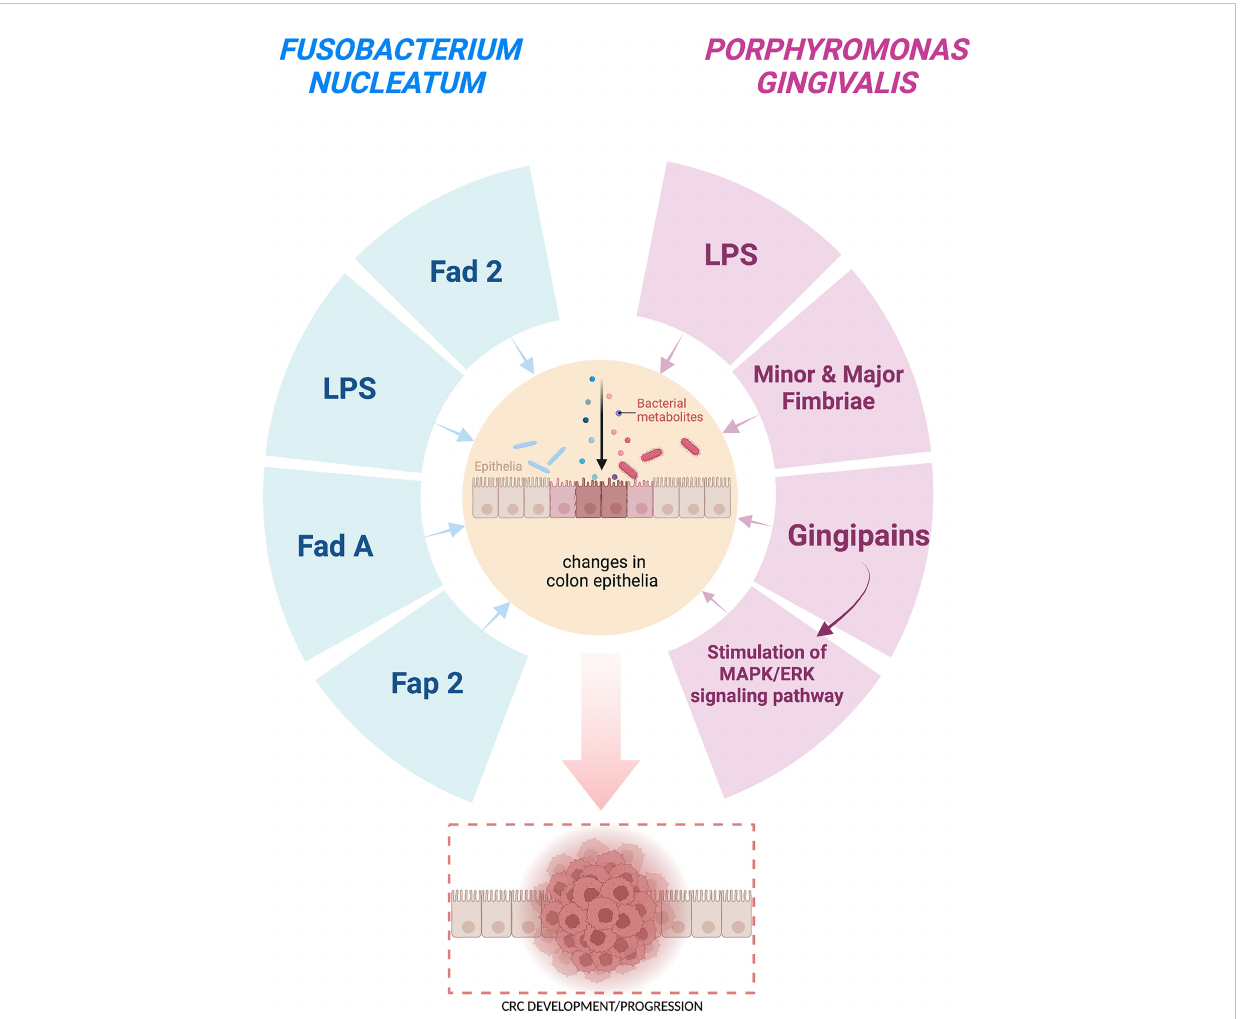
FIGURE 1 Carcinogenic effect of the virulence factors of Fusobacterium nucleatum and Porphyromonas gingivalis on the colon cells leading to CRC development/progression. Fad 2 – adhesin and invasion, LPS – lipopolysaccharides, Fad A – adhesin, Fap 2 – fusobacterium autotransporter protein 2, Gingipains – cysteine proteinases. This fi gure was created using Biorender.com